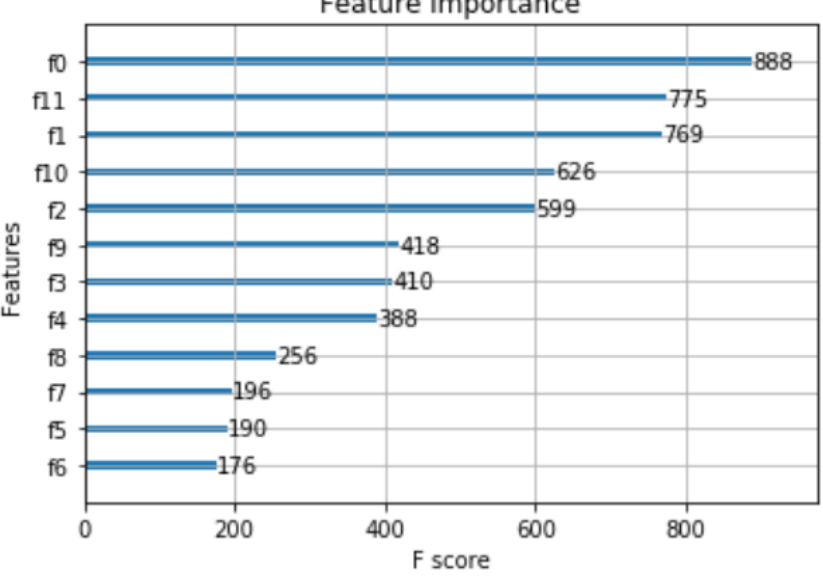
Figure 4. Feature importance of same pixel of previous months, where f(0) stands for same month previous year, and f(11) stands for previous